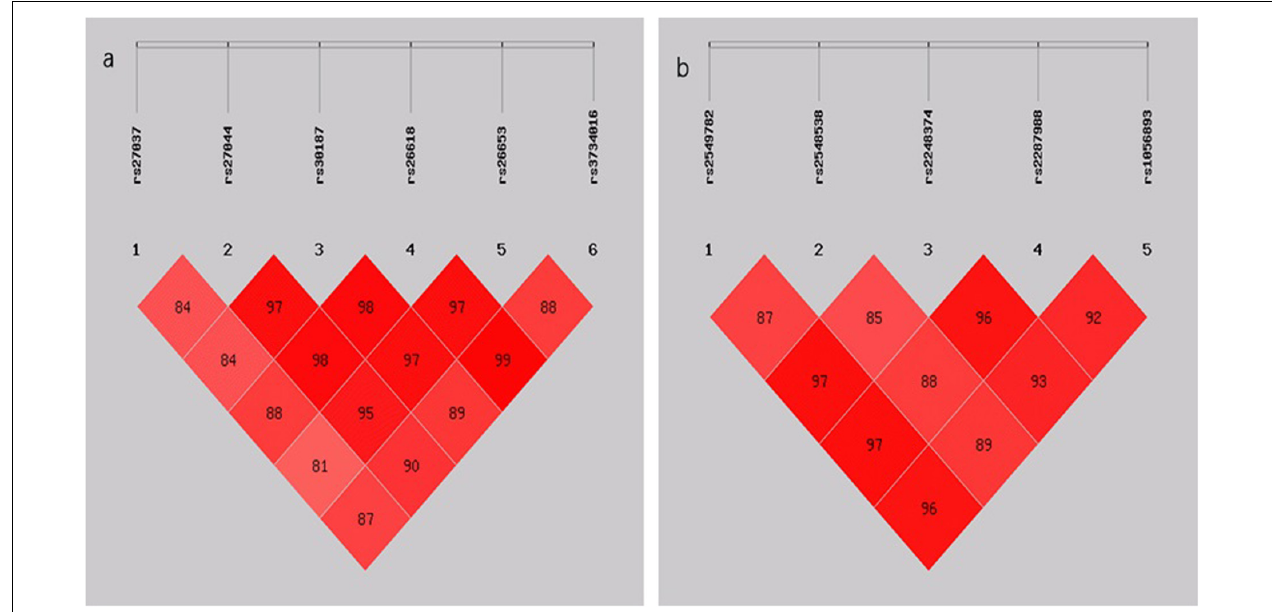
FIGURE 1 | (A) LD pattern of the five SNPs genotyped in the ERAP1 gene; (B) LD pattern of the five SNPs genotyped in the ERAP2 gene. The plots show D’ × 100 values as a pair of LD.